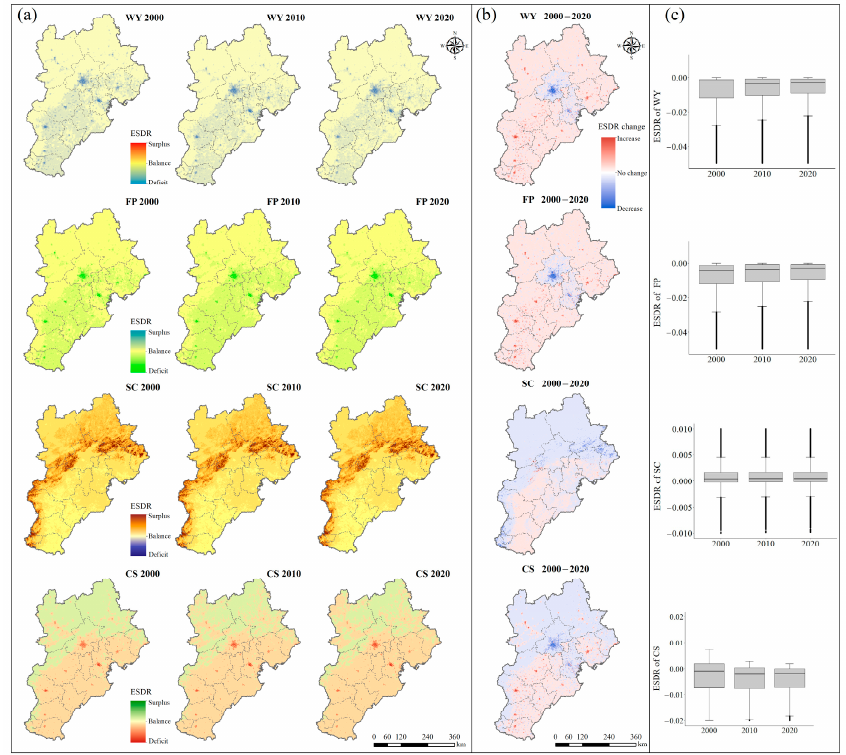
Figure 4. Spatial pattern and change of four ESDRs for carbon fixation (CF), water provision (WP), food provision (FP), and soil conservation (SC) from 2000 to 2020. ( a ) Spatial patterns of ESDRs, ( b ) spatial changes of ESDRs, and ( c ) changes in mean values of ESDRs.